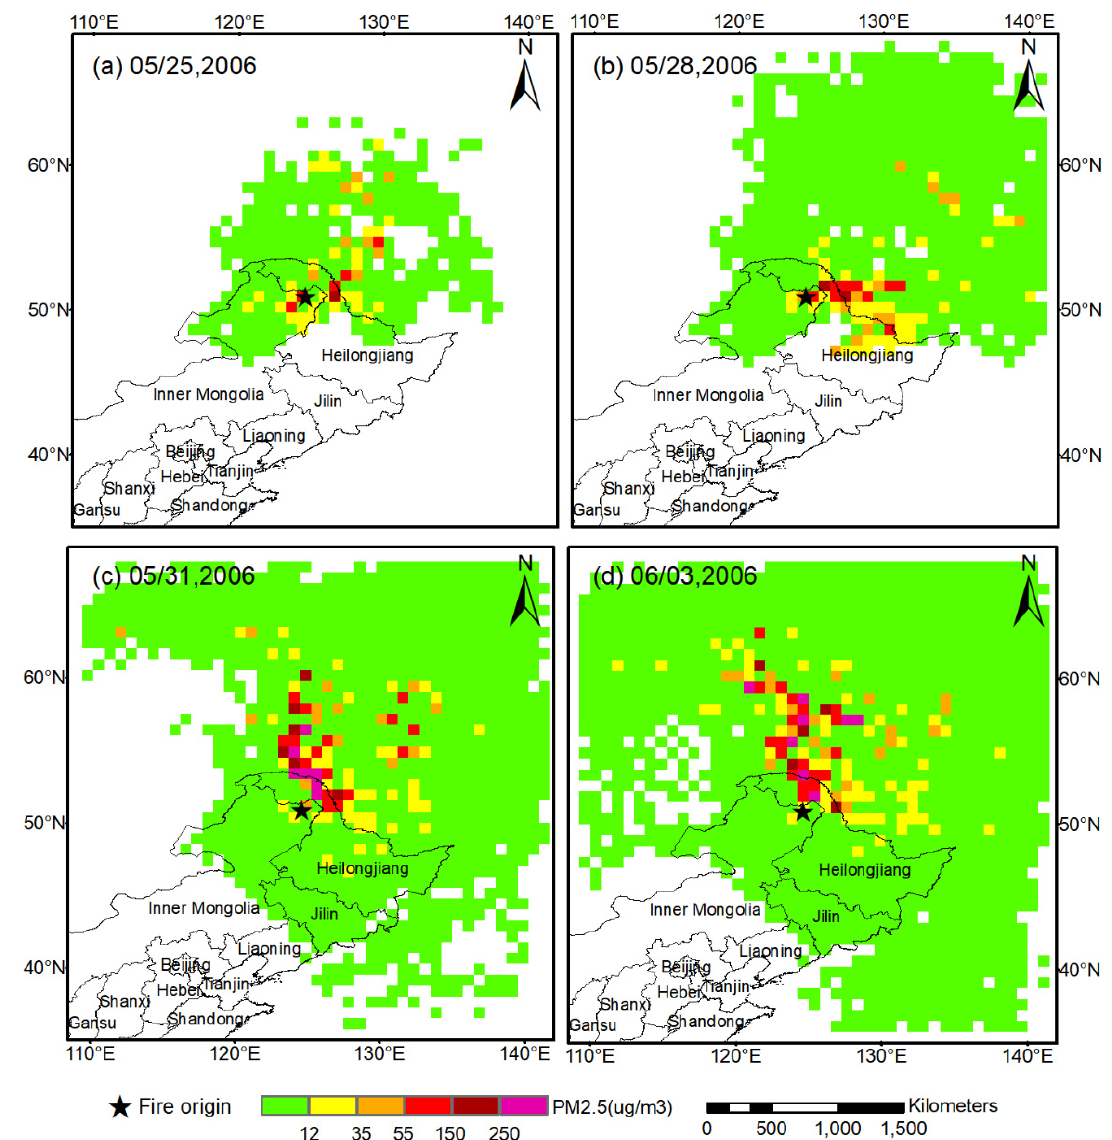
Figure A2. Same as Figure A1 except for the Songling fire. Panels ( a – d ) are 25, 28, and 31 May and 3 June 2006, respectively.